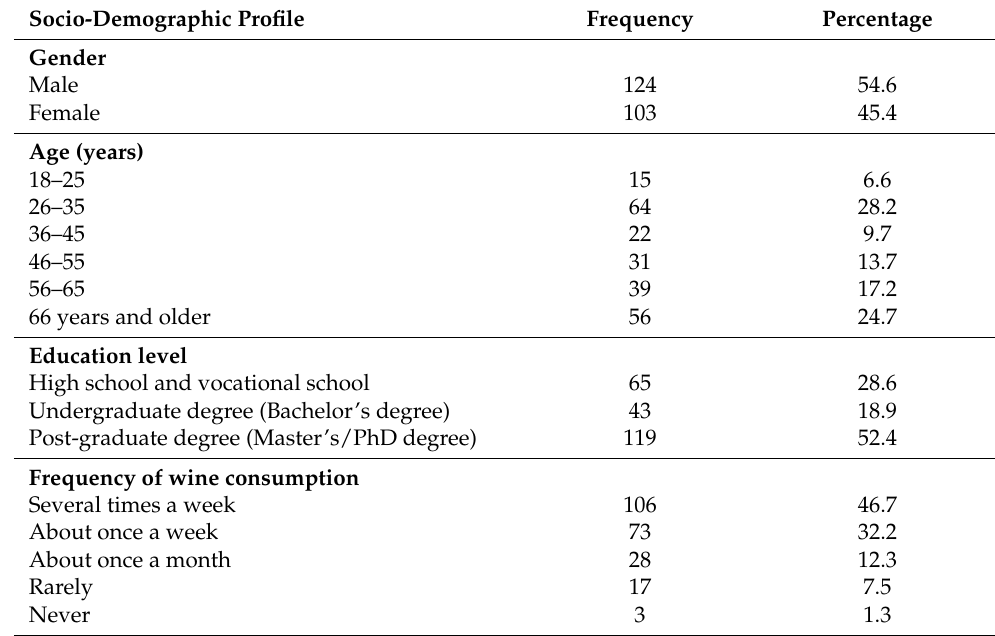
Table 1. Socio-demographic characteristics of respondents and wine